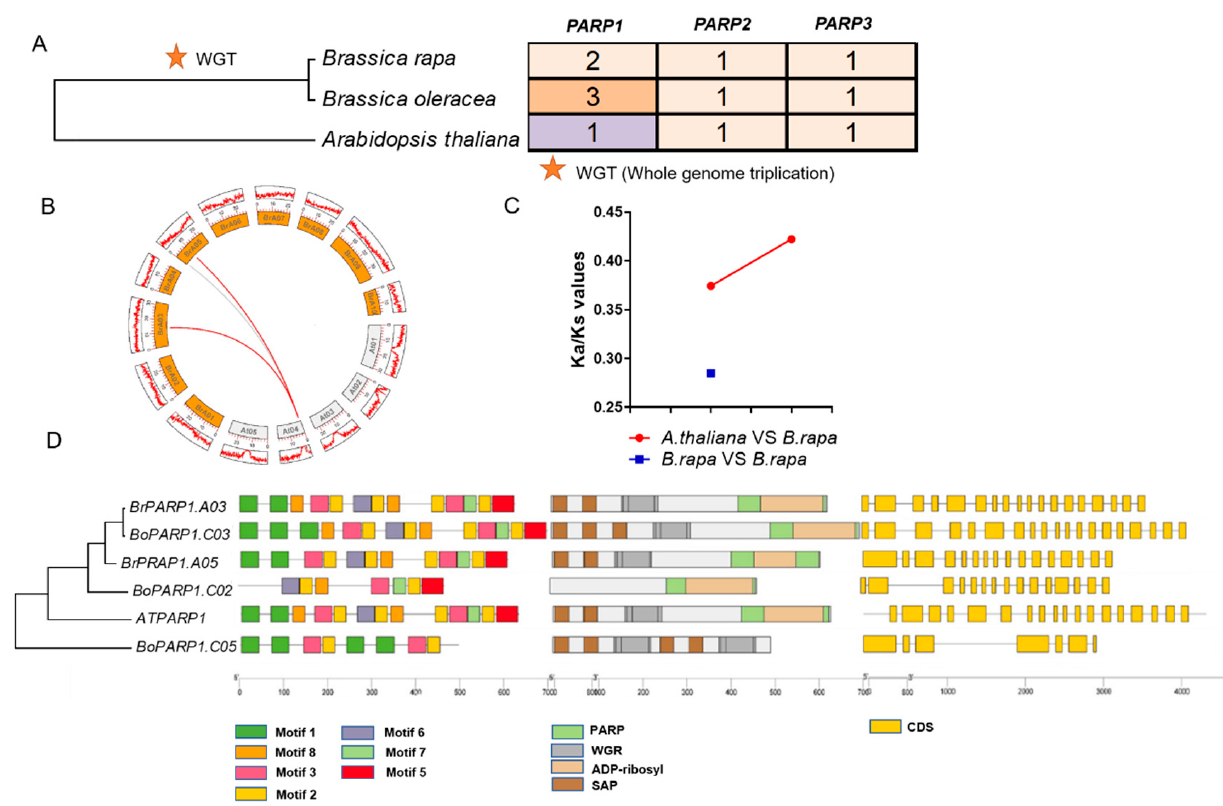
Figure 1. PARP genes following WGT in brassicas. ( A ) The number of PARP genes copies retained in Arabidopsis and Brassica species. The phylogenetic tree resulting from the evolution of species. ( B ) Collinear correlations of Br PARP1 genes and neighboring genes in the A. thaliana and B. rapa genomes. The B. rapa and A. thaliana chromosomes are colored in accordance with the inferred ancestral chromosomes following a set up convention. The lines of Br PARP1 genes are red and lost genes are gray. The figure was created using Circos software. ( C ) The Ka/Ks value of B. rapa and A. thaliana PARP1 orthologous gene pair and paralogous gene pair. ( D ) Gene structures and conserved motifs of PARP1 . The unrooted phylogenetic tree resulting from the full-length amino acid alignment of all of the PARP1 proteins. The tree was constructed the usage of maximum likelihood (ML) and bootstrap values calculated with 1000 replications using MEGA7.